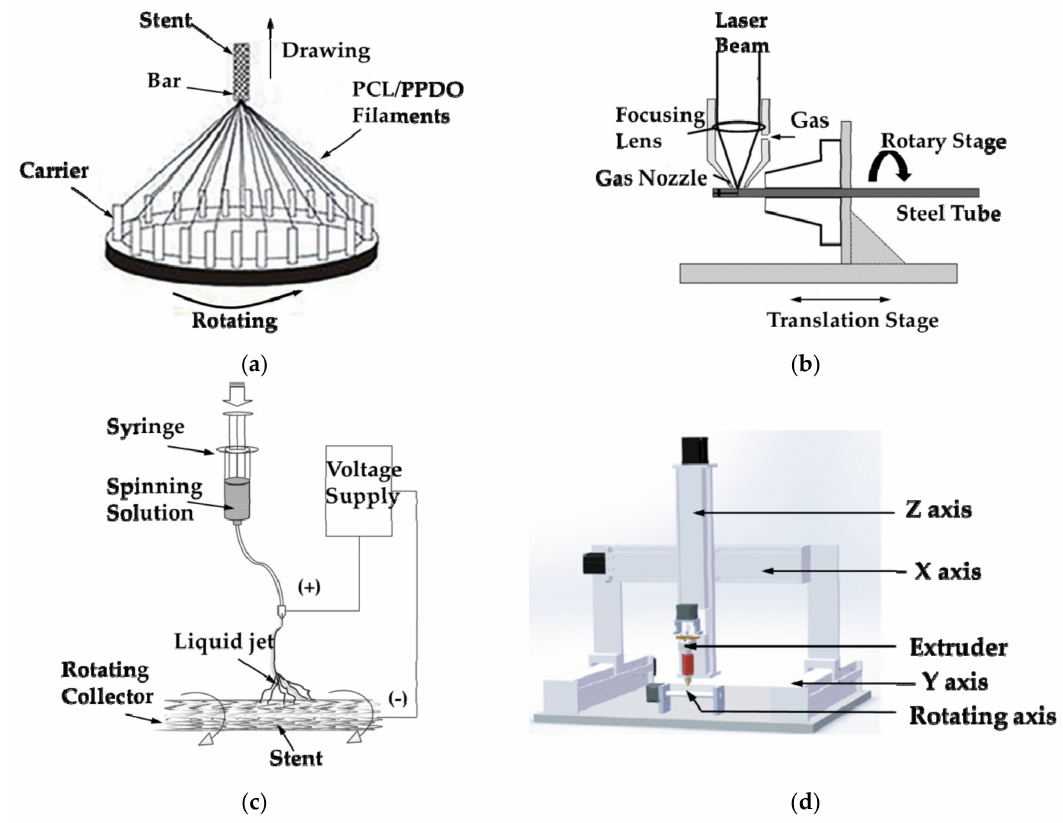
Figure 7. Vascular stent processing method: ( a ) Braided [77]; ( b ) Laser cutting [80]; ( c ) Electrospinning technology [86]; ( d ) Additive manufacturing